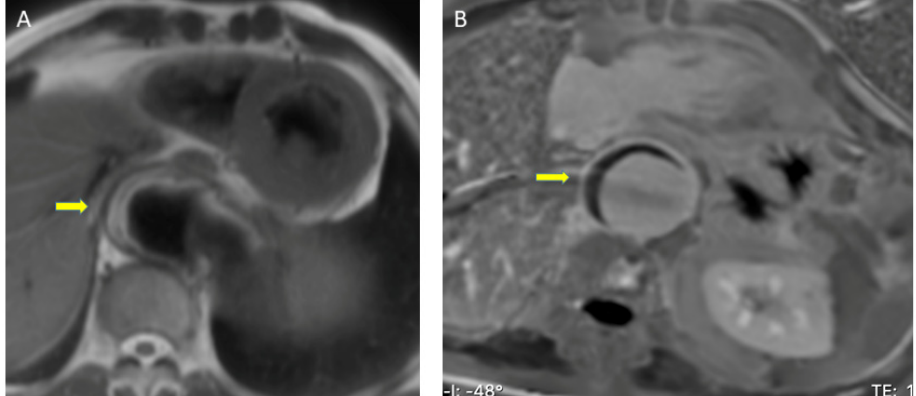
Figure 4. Magnetic resonance imaging assessment of intramural hematoma (arrows). ( A ) Spin-Echo sequence. The eccentric thickening of the aortic wall has a high T1 signal, eliminating the possibility that it is an acute stage. ( B ) Late gadolinium ‐ enhancement sequence. Aortic eccentric wall thickening with no mural enhancement, suggestive of intramural hematoma.